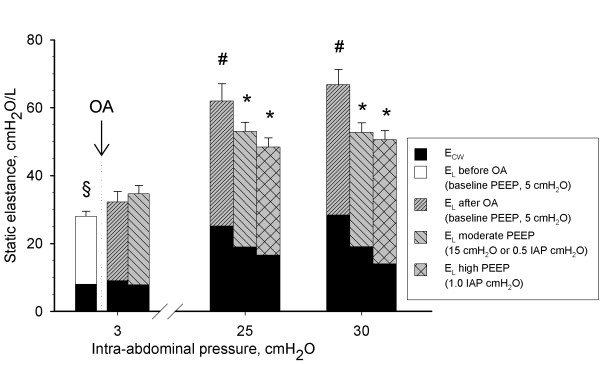
Static elastance of the total respiratory system (ERS) as a composite of chest wall (ECW, black filled bar) and lung elastance (EL, white or grey filled bar) in function of different levels of intra-abdominal hypertension (IAH) (baseline (3 cmH2O), grade II IAH, (25 cmH2O = 18 mmHg), and grade III IAH (30 cmH2O = 22 mmHg)) at different degrees of IAP-matching levels of positive end-expiratory pressures (PEEP). OA, oleic acid. Mean and SE (ERS) are shown. ANOVA and post hoc Student-Newman-Keuls were used for statistical testing. §, P <0.05 comparing ERS before and after oleic acid. *, P <0.05 ERS within an IAP setting versus the corresponding value at 5 cmH2O PEEP. There were no significant differences in ERS within an IAP setting comparing moderate versus high PEEP. #, P <0.05 ERS within a PEEP setting versus the corresponding value at baseline IAP. ANOVA, analysis of variance.